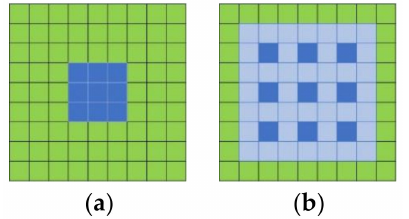
Figure 6. Convolution process. ( a ) Convolution; ( b ) dilated